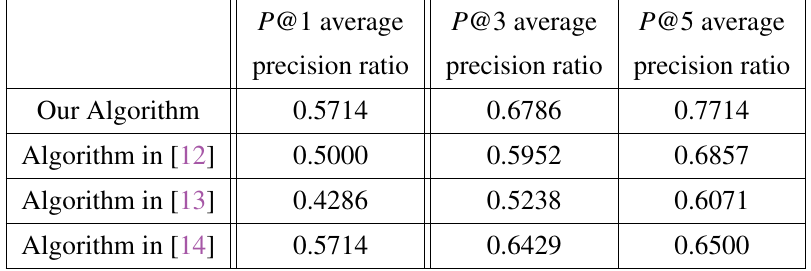
Table 5 Tab. 5. The Experiment Results of Ontology